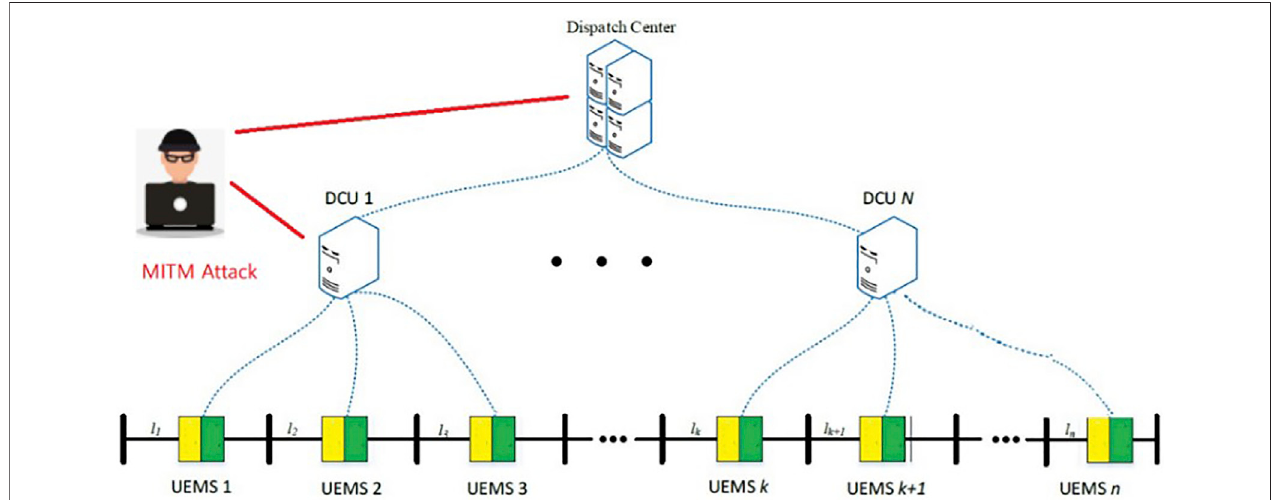
FIGURE 2 | MITM attack mode between DCUs and dispatch center